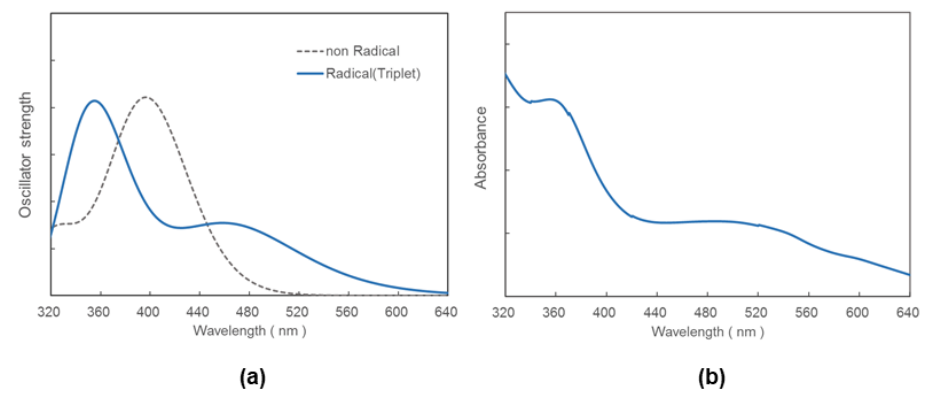
Figure 3 Figure 3. ( a ) The theoretical absorption spectra calculated for the singlet and triplet spin configu- rations of [Ru(apy) 2 (CO) 2 ] 2+/0 at the TDDFT/B3LYP/LanL2DZ/6-31G(d) level of theory; ( b ) The absorption spectrum of [Ru(apy · − ) 2 (CO) 2 ].